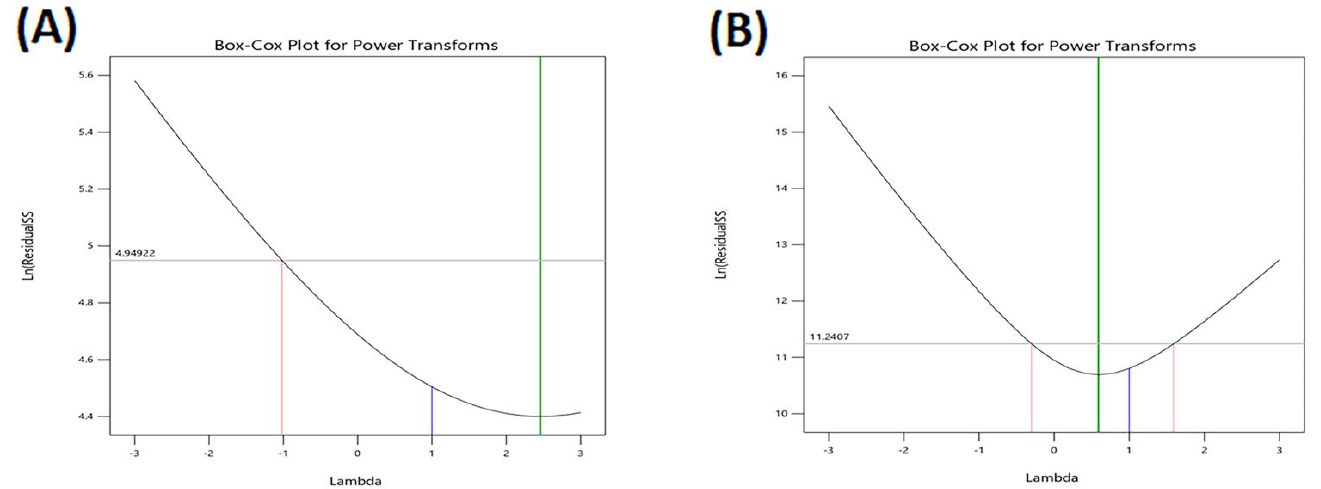
Figure 2. Box–Cox plot of all responses. EE: entrapment efficiency ( A ); VS: vesicle size ( B ); ZP: zeta potential ( C ); Q21 h: cumulative amount of DNa permeation ( D ). 2.2. DNa-BSVCs Characterization 2.2.1. Effect of Independent Variables on EE% As illustrated in Table 2, DNa entrapment was in the range of 61.7–93.2% for all vesicles. The combined effect of the two independent variables (span type and bile salt type) on the EE% of DNa-BSVCs at the lowest levels of the third variables (bile salt concentration) is demonstrated in (Figure 3A). The significant impact of independent factors on the EE% of DNa-BSVCs was shown in (Table 1).